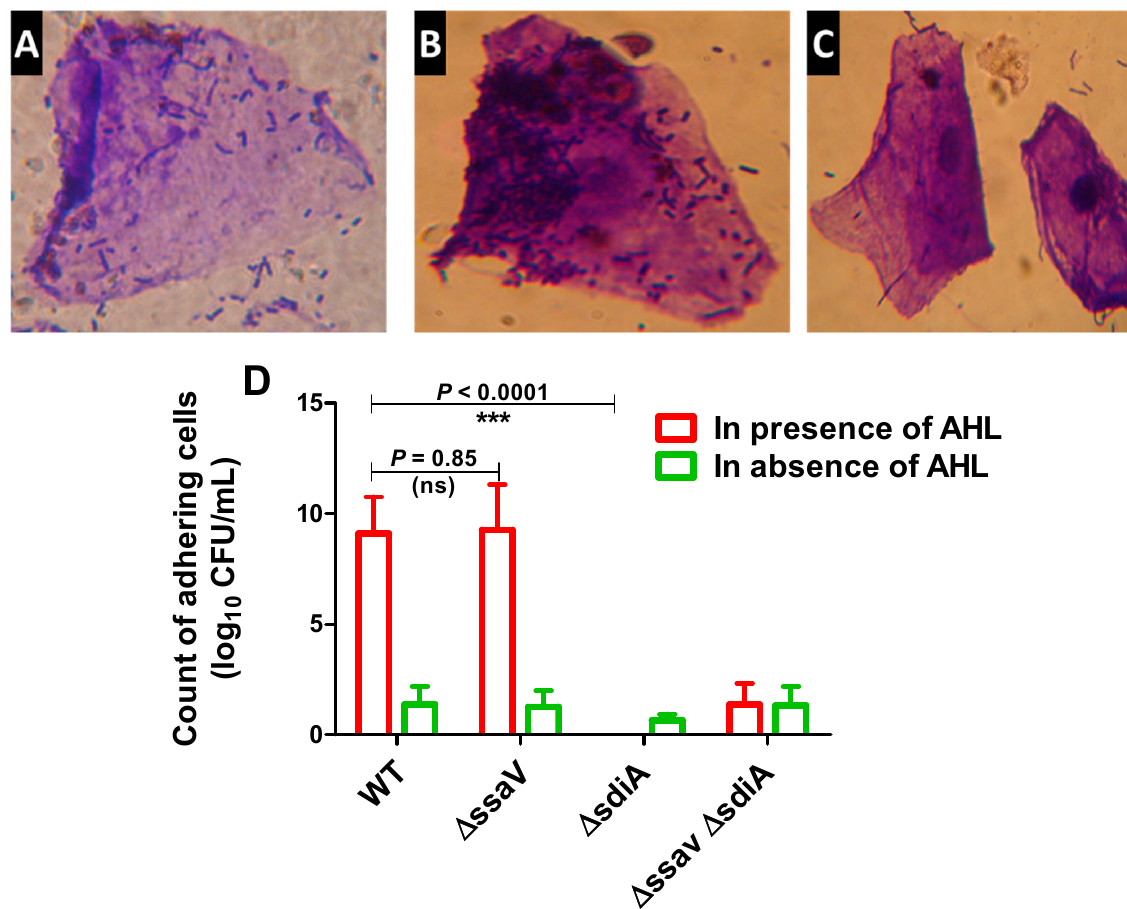
Figure 3. Adhesion of S. enterica strains to HeLa cells. HeLa cells were co-cultured with S. enterica WT, Δ ssaV , Δ sdiA or Δ sdiA Δ ssaV both in the presence and absence of AHL for 1 h at 37 °C. Microscopic examination of crystal violet-stained adhering S. enterica to HeLa cells either in presence or absence of AHL. ( A ) S. enterica WT adhesion in absence of AHL, ( B ) Salmonella enterica WT adhesion in presence of AHL and ( C ) S. enterica Δ sdiA mutant adhesion in presence of AHL. ( D ) AHL significantly increases adhesion of S. enterica WT and Δ ssaV but not Δ sdiA and Δ sdiA Δ ssaV mutants to Hela cells. Epithelial cells were lysed with Triton X-100 (1%). Adhering bacteria were serially diluted and counted on agar plates. Experiment was performed in triplicate, and results are represented as means ± standard deviations; p -value < 0.05 was considered statistically significant, using a Student’s t -test (*** = p < 0.001).